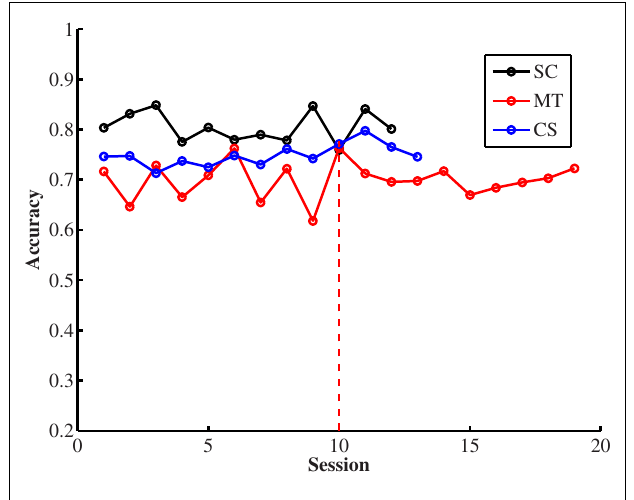
FIGUREA2 | Mean accuracy as a function of session for the three subjects in Experiment 1B. For SC and CS, whose performance was relatively high and stable, all sessions were maintained for the analysis. For subject MT the sessions 1–10 (up to the red vertical line) were eliminated because the participant’s accuracy was unstable.